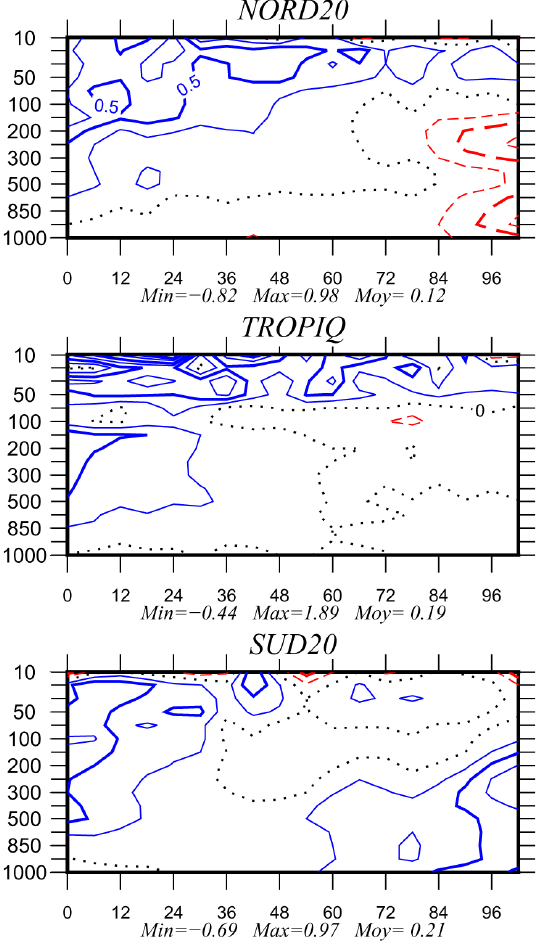
Fig. 7. Impact of tuning on forecast scores: differences between the root mean squared errors of the reference and of the experiment compared to independent ECMWF analyses (geopotential error in m), as a function of forecast range (in h). NORD20 is the domain on the globe that is north of 20 ◦ N, TROPIQ is the domain between 20 ◦ N and 20 ◦ S, and SUD20 is south of 20 ◦ S. Blue (red) indicates better (worse) performance. The verification period is one month (September